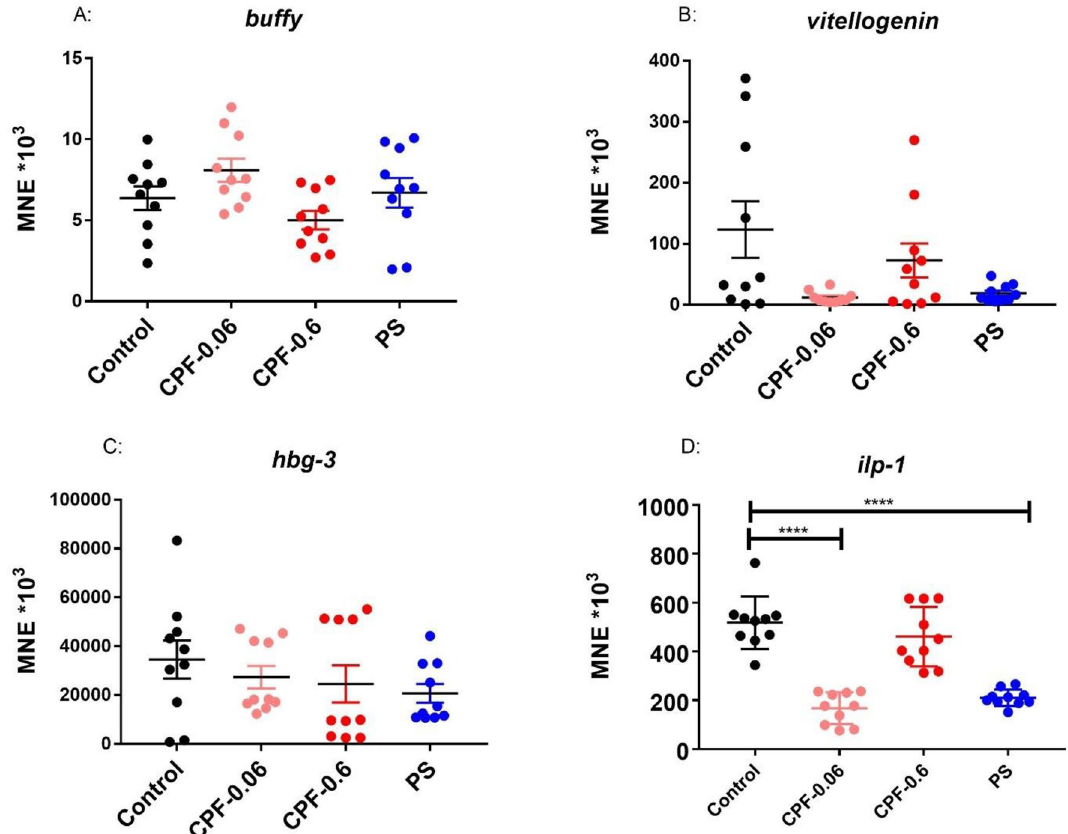
Figure 4. Abundance of endocrine transcripts buffy ( A ), vitellogenin ( B ), hbg-3 ( C ) and ilp-1 ( D ) in foragers of the same age after 24 h exposure to 0.06 and 0.6 ng/bee CPF and 2.65 microg/bee PS, respectively (black dots: controls, light and dark red dots: CPF, blue dots: PS, n = 10). Significant changes are marked with